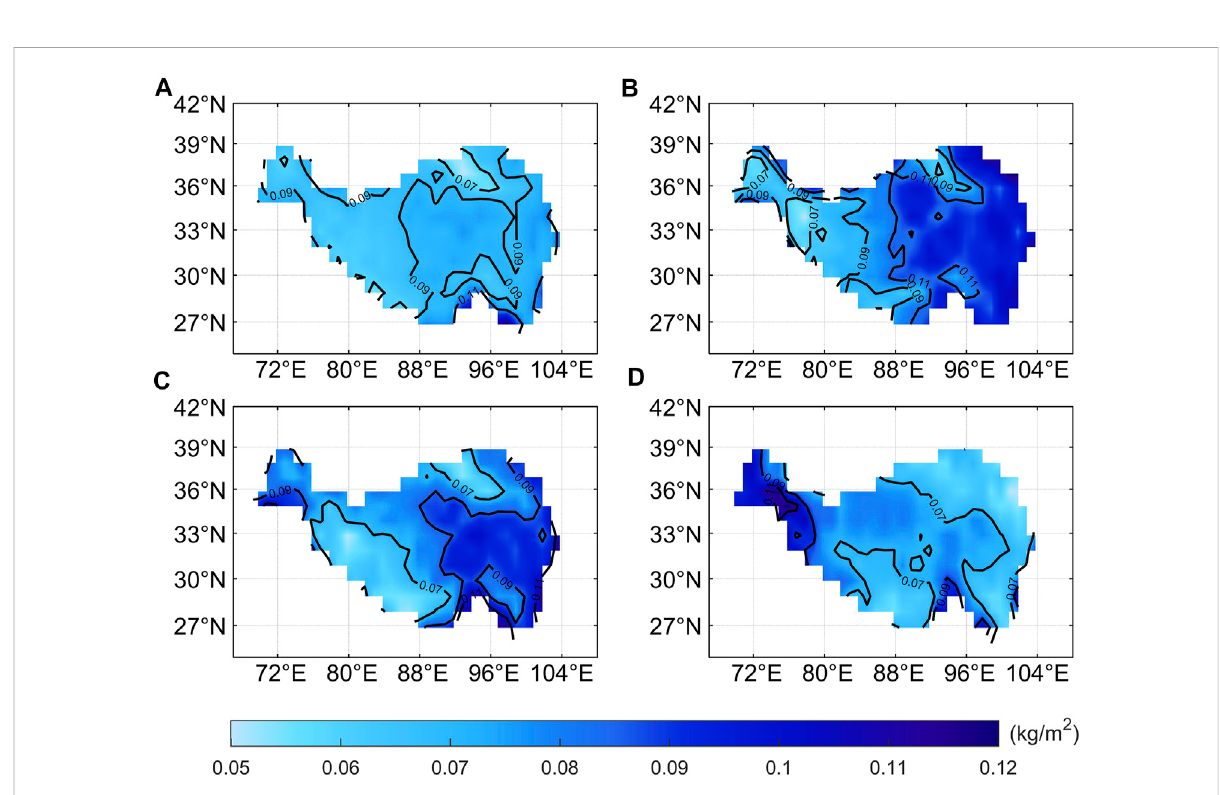
Spatial distributions of atmospheric ice over the TP in different seasons retrieved by the Aqua satellite from 2003 to 2020. (A) Spring (MAM), (B) summer (JJA), (C) autumn (SON), and (D) winter (DJF).